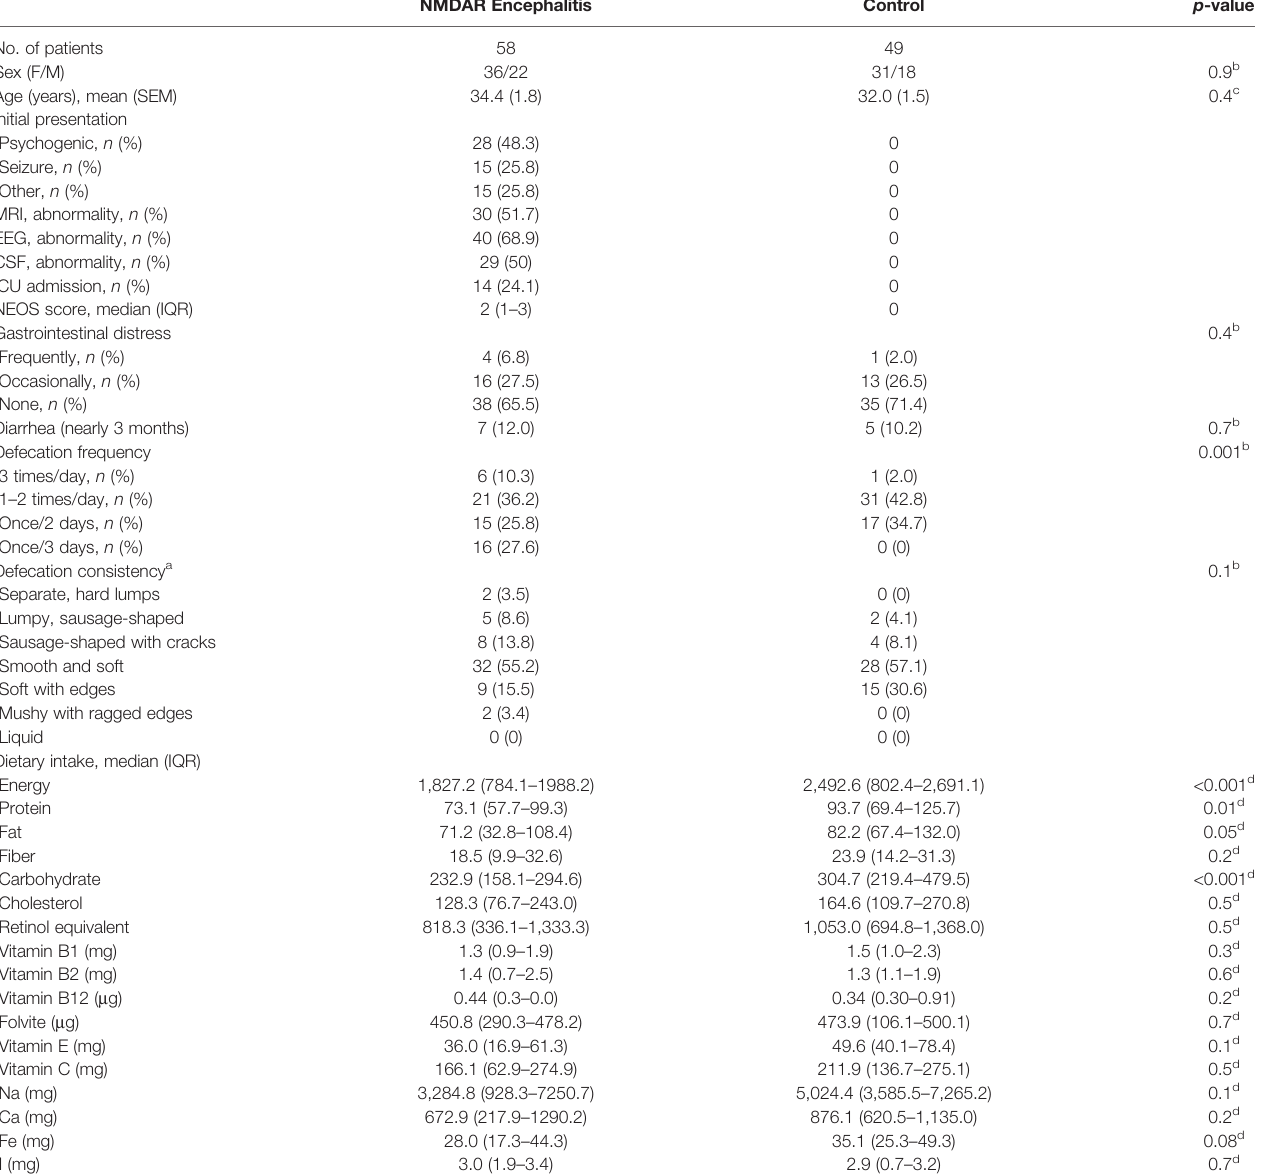
TABLE 1 | Extrinsic host factor pro fi le including diet, stool consistency, and lifestyle in anti- N -methyl- D -aspartate receptor (NMDAR) encephalitis patients and control